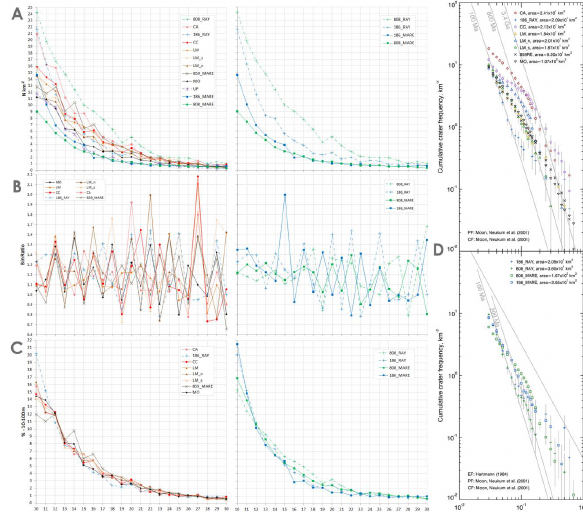
Figure 2. A – histogram of number of craters per 1 m bin size per km -2 (i.e., density); B – ratio between adjacent Nkm -2 bins; C – bin sizes 10 to 100 m factorised to unit, in this case 100 to give percentage; D – pseudo-log binned histogram for sizes >30 m using CraterstatsII (Michael and Neukum, 2010). Each data point is not fit to isochrones, which are drawn for reference only. See APPENDIX for full size image